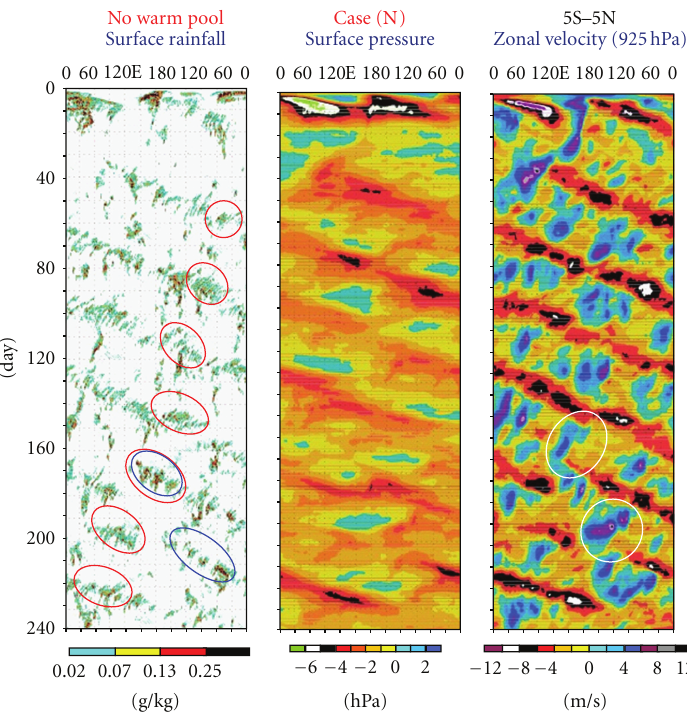
Figure 1: Longitude-time sections (Hovm¨ollor diagrams) of rainwater mixing ratio at the low level (the lowest level of the model, P B = 996hPa), surface pressure, and zonal velocity at P B = 925hPa in case (N). Values averaged for 5S–5N are shown.